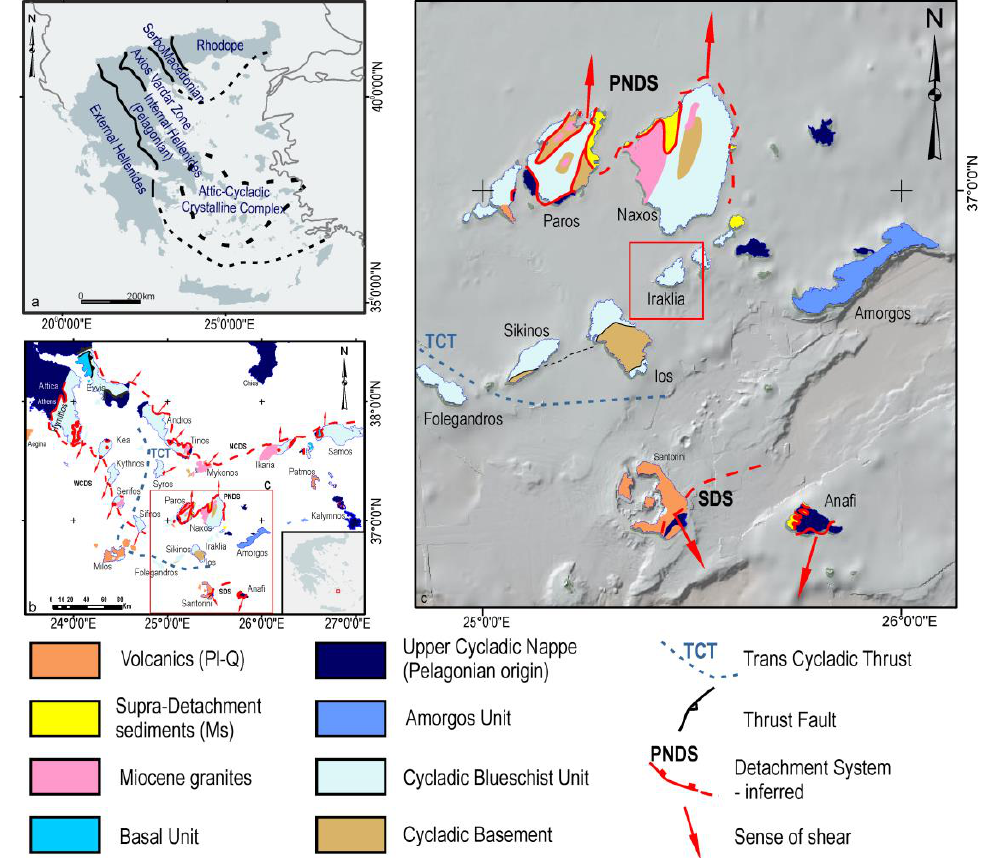
Figure 1. ( a ) Schematic map of major structures in Greece, ( b ) detailed map of the ACCC illustrating the main units, the major structures, and ( c ) simplified geology of Iraklia and neighboring islands (base map made from GeoMapApp https://www.geomapapp.org, accessed on 20 December 2021). Trans Cycladic Thrust (TCT), North Cycladic Detachment System (NCDS), Paros-Naxos Detachment System (P-NDS) West Cycladic Detachment System (WCDS), and Santorini Detachment System (SDS) compiled from